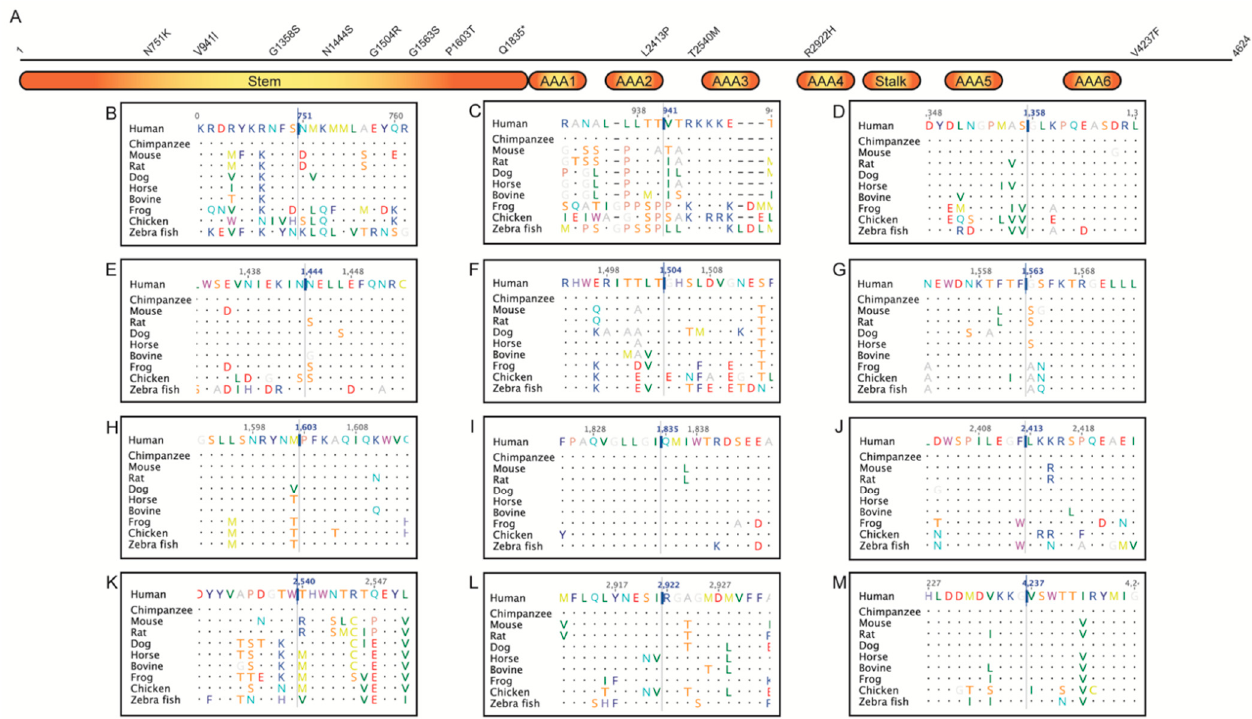
Figure 2. ( A ) Schematic representation of the DNAH5 protein (4624 amino acids). Stem, stalk, and ATPases Associated with a variety of cellular Activities (AAA) regions are shown as blocks. Missense and nonsense variations identified here are displayed above the block diagram. Twenty-one amino acid regions, centered around missense/nonsense variations, obtained from a multiple sequence alignment of DNAH5 proteins from human, chimpanzee, mouse, rat, dog, horse, bovine, frog, chicken, and zebra fish are shown in B-M–( B ) N751K (c.2253C>A); ( C ) V941I (c.2821G>A); ( D ) G1358S (c.4072G>A); ( E ) N1444S (c.4331A>G); ( F ) G1504R (c.4510G>C); ( G ) G1563S (c.4687G>A); ( H ) P1603T (c.4807C>A); ( I ) Q1835Ter (c.5503C>T); ( J ) L2413P (c.7238T>C); ( K ) T2540M (c.7619C>T); ( L ) R2922H (c.8765G>A); ( M ) V4237F